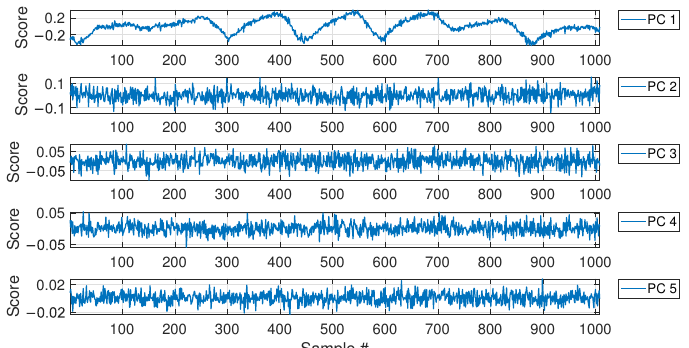
Figure 17. PC scores for the baseline set of eigenfrequencies containing a number b = 1008 of observations, considering real temperature trends.